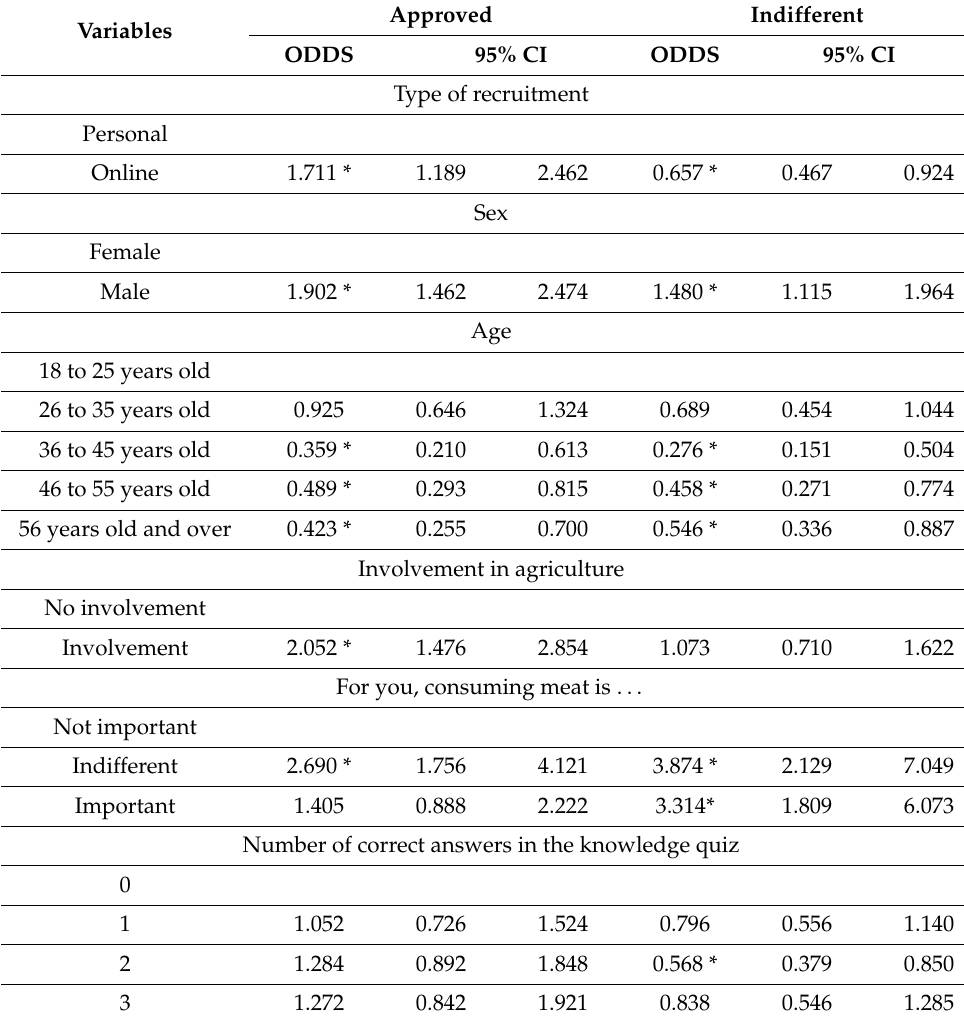
Table 3. Odds ratio (ODDS) and 95% confidence interval (95% CI) for multinomial logistic regression models of opinion towards approval of humane consumption of animals housed in “hospital pens” (Q3). Reference category was